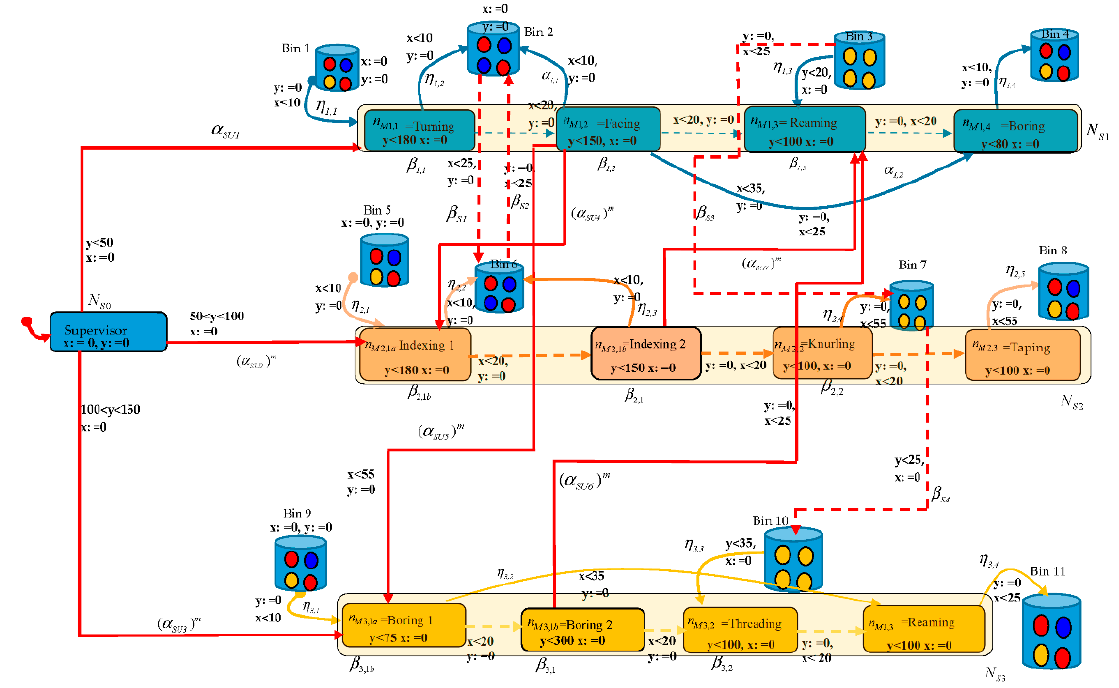
Figure 9. Supervisor Machine Model.